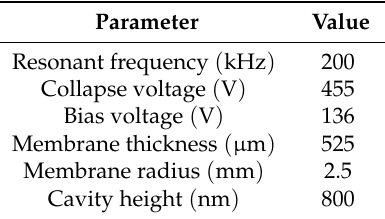
Table 1. CMUT design